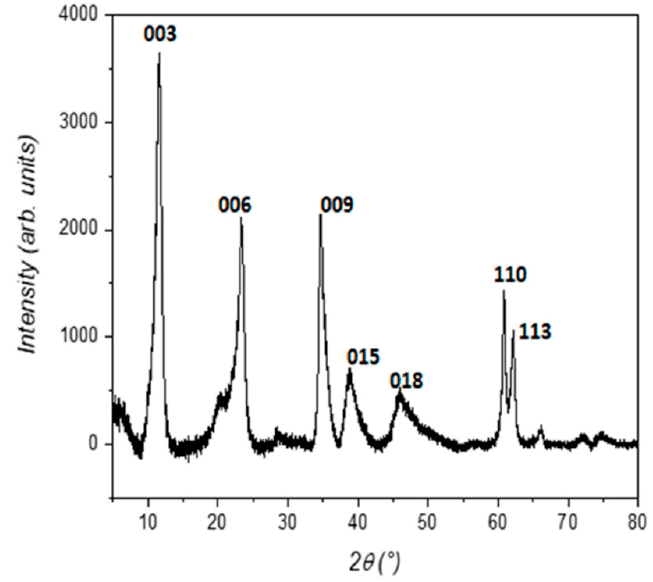
Figure 1. Powder X-ray diffraction pattern of the LDH synthesized. With regard to morphology, Figure 2 reveals a homogeneous structure, which tends to transform into lamellae. The typical flower-like lamellar organization was not detected in through coprecipitation synthesis followed here [27]. EDX analysis of the sample further confirmed the ratio of the two metals in the